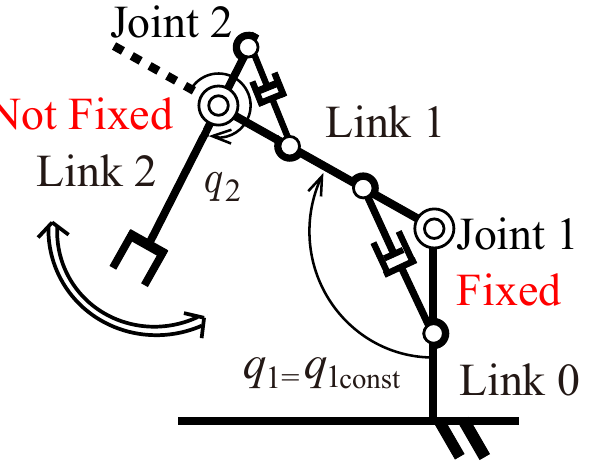
Figure 3. Physical parameter identification motion (joint 1 is fixed and only joint 2 is driven (not fixed) without loss of